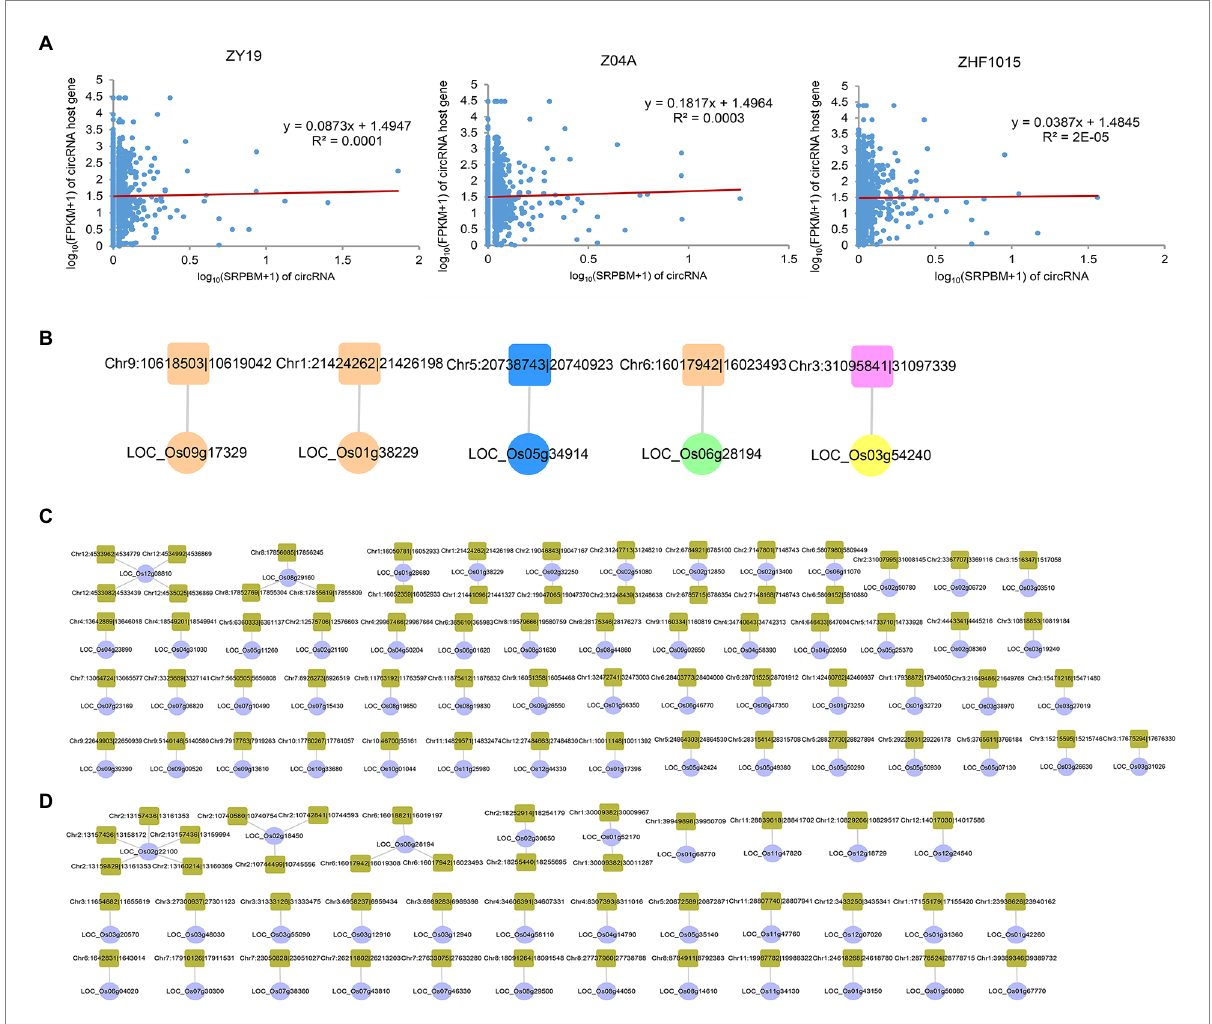
FIGURE 7 Regulatory networks of circRNAs and their host genes. (A) Correlation analysis of circRNAs and their host genes. (B) Regulatory network of DEcircRNAHPs and their host DEGHPs. The host DEGHPs and DEcircRNAHPs were represented by circle and square. The colors of the different types of RNA were consistent with those illustrated in Supplementary Figure S9. (C) circRNA-host ASEG-M network. The host ASEG-M and circRNA were represented by circle and square. (D) circRNA-host ASEG-P network. The host ASEG-P and circRNA were represented by circle and